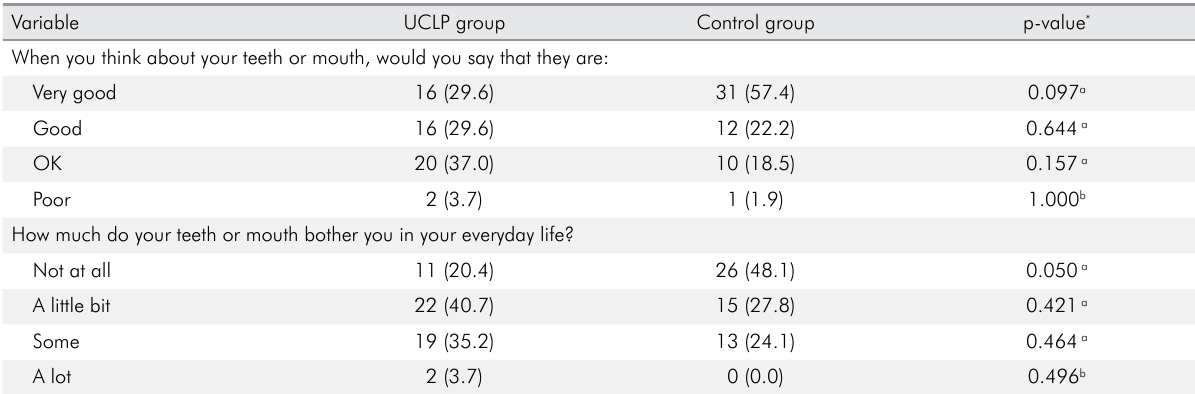
Table 4. Distribution [n (%)] of responses to global ratings by group. Variable UCLP